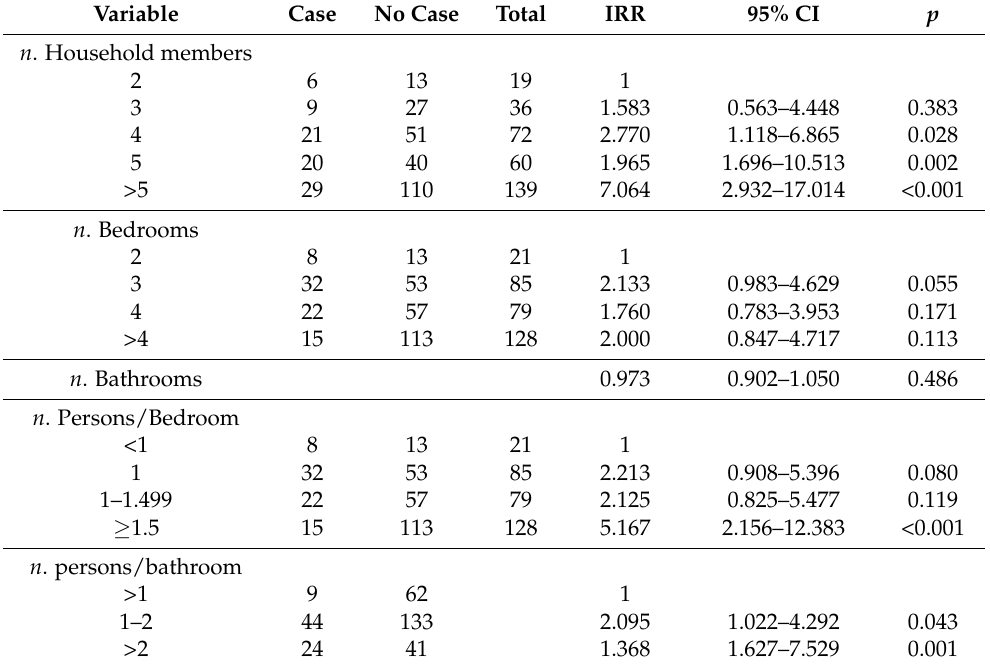
Table 3. Univariate Exact Poisson regression of secondary transmission by household characteristics of index